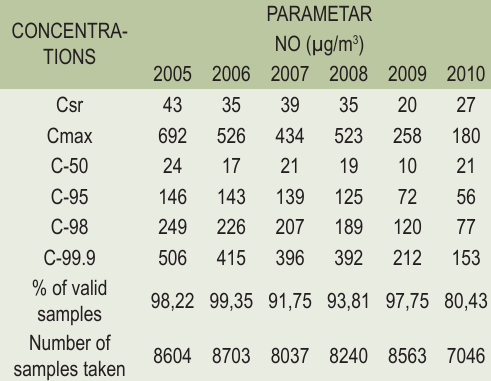
TABLE 3. Statistical overview NO concentration μ g / m³ (hourly samples) Sarajevo-automatic station Bjelave